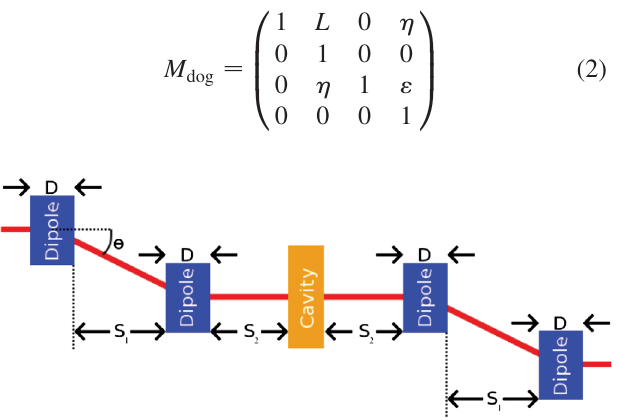
FIG. 1. Basic EEX